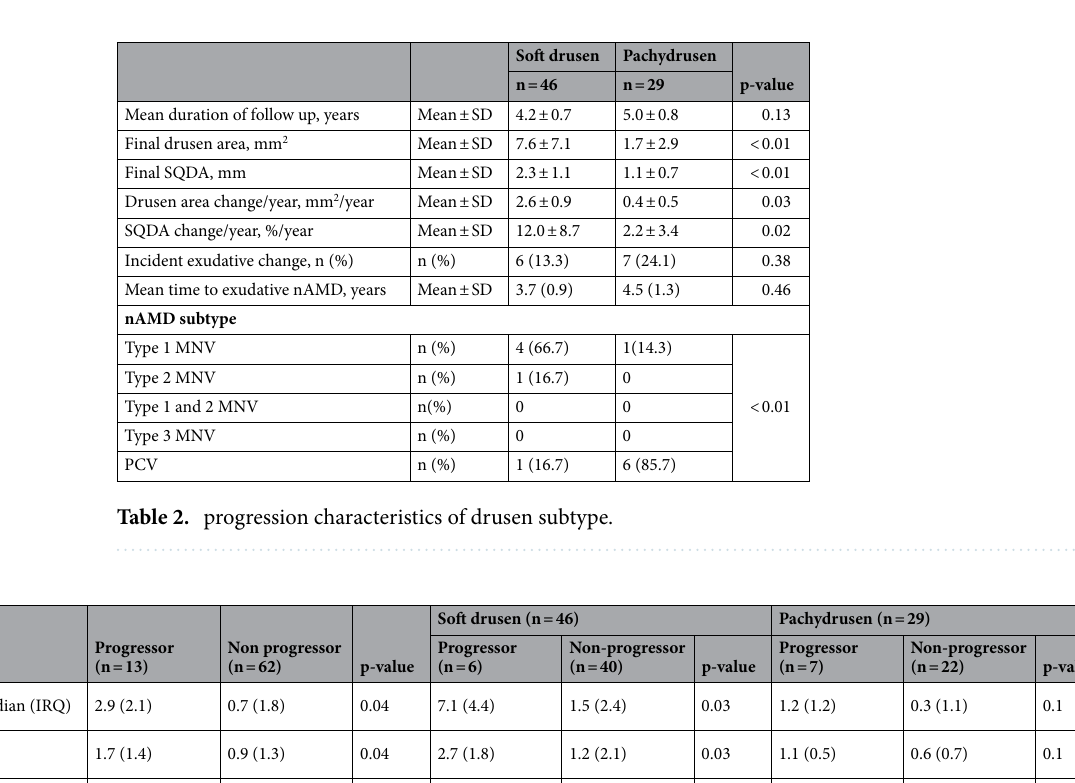
Figure 1. Proportion of drusen subtypes at different locations. A larger proportion of eyes with soft drusen had drusen located more centrally (within a 500 µm radius circle centred on the fovea) than in the outer areas and conversely, larger proportion of eyes with pachydrusen had drusen located in the outer ring (defined by an area bounded by an inner radius of 1500 µm to the visible extent of the photograph).